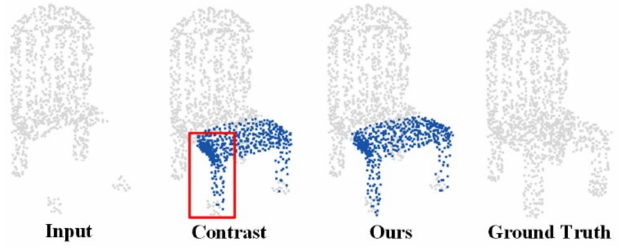
Figure 10. Comparison experiment of boundary extraction methods. Table 4. Pred → GT and GT → Pred error obtained via boundary and projection as encoder